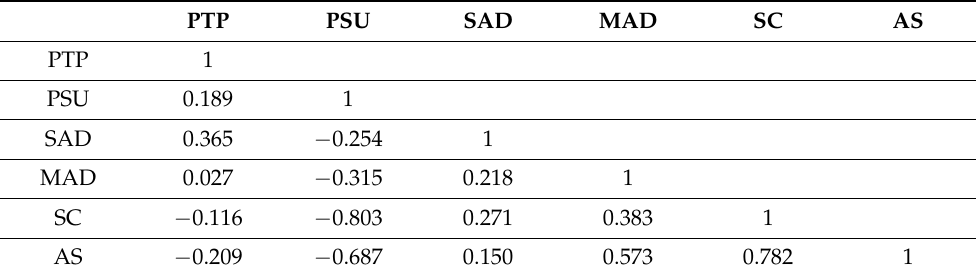
Table 3. Heterotrait-monotrait ratio